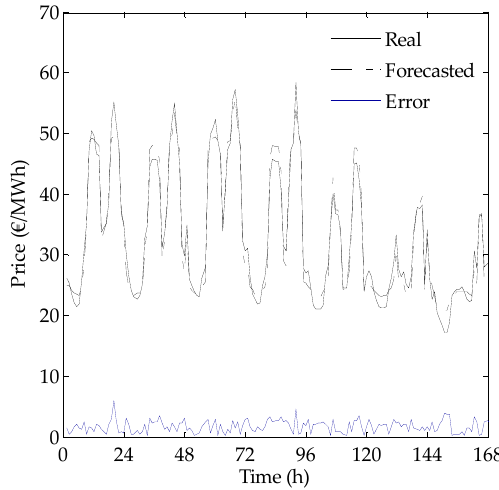
Figure 8. Autumn week 2002 results for the Spanish market.